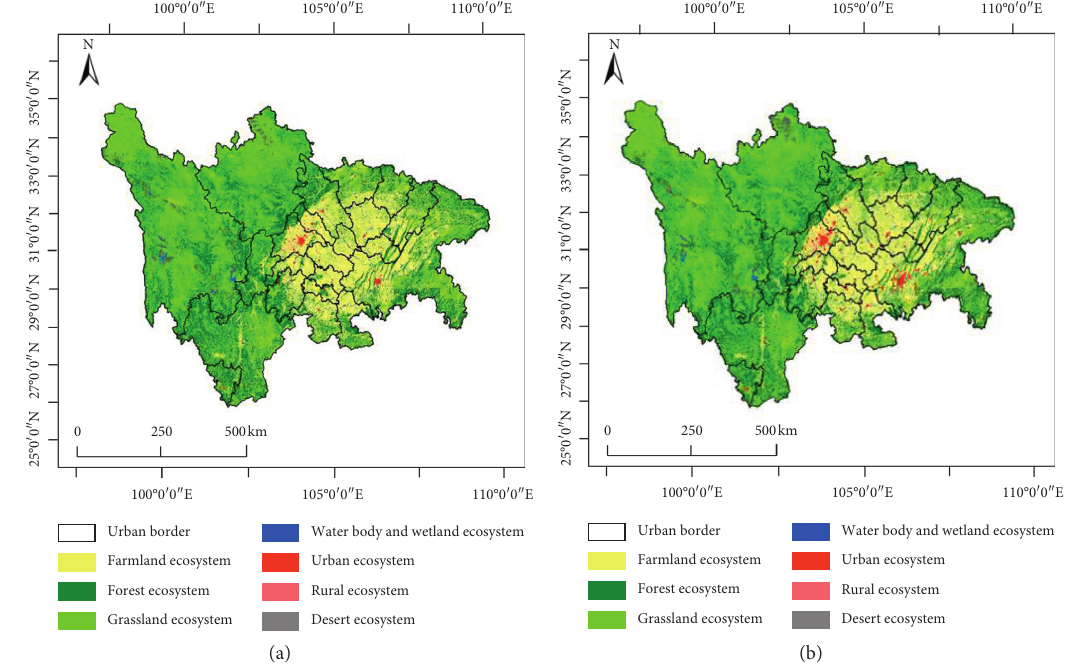
Figure 2: The spatial distribution of ecosystem between 2005 and 2015 in Sichuan-Chongqing region. (a) 2005. (b)